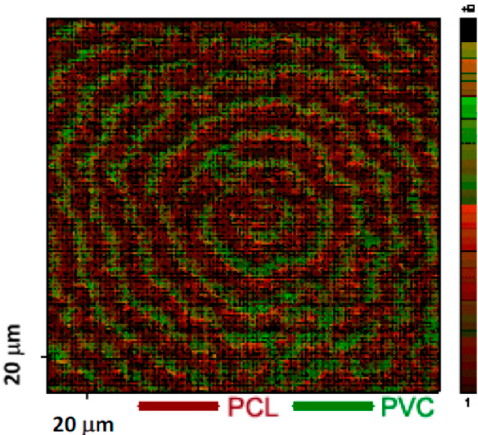
Figure 3. Ion map of the blend of PCL and PVC grown at 45 °C [41].